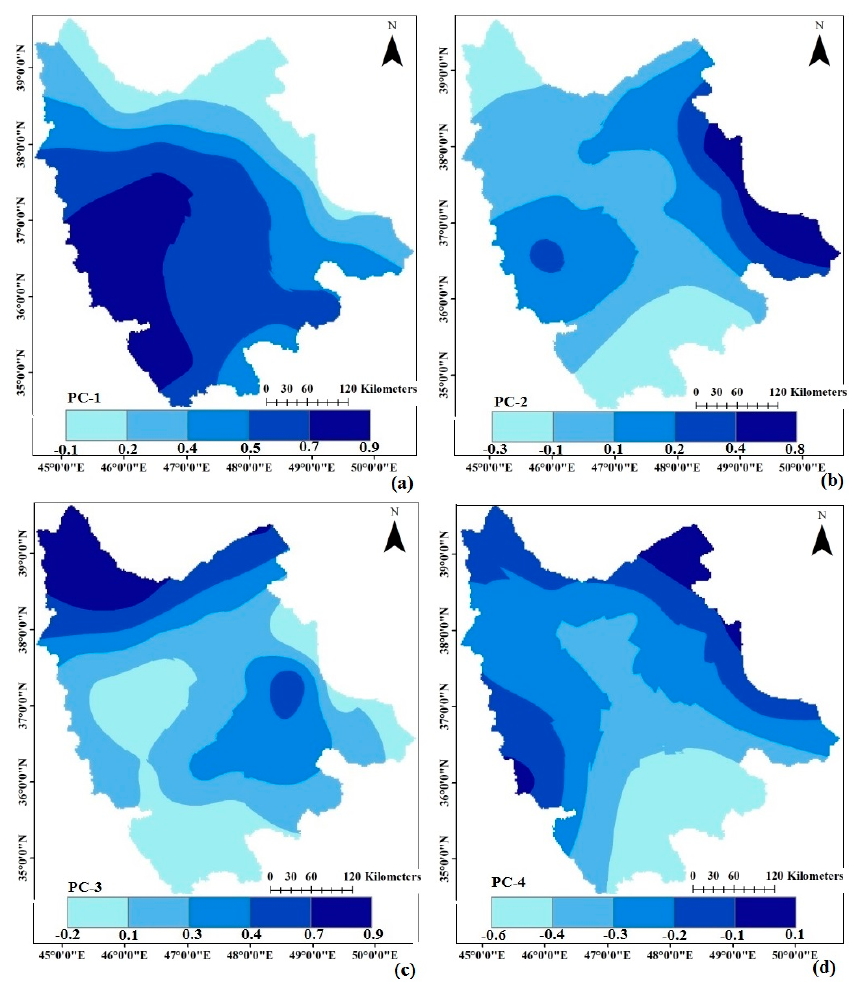
Figure 6. Spatial distribution of Varimax rotated principal component (PC) scores of mean annual rainfall, ( a ) PC-1; ( b ) PC-2; ( c ) PC-3; and ( d ) PC-4.